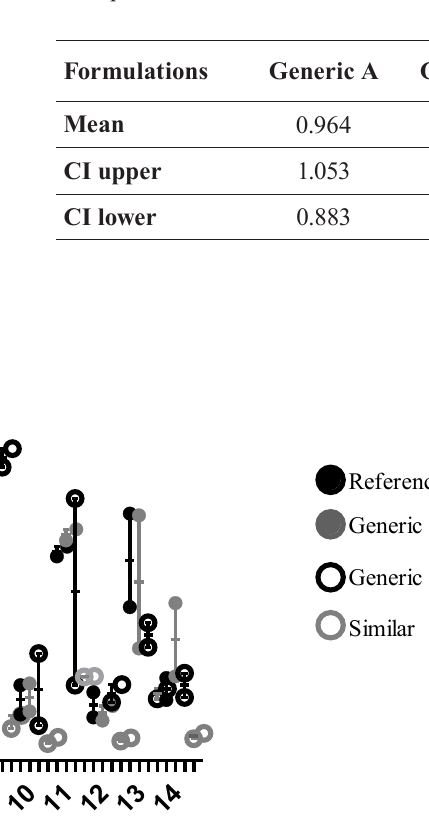
TABLE III - In vivo bioequivalence assessment ratio of products containing mupirocin (generic A, B and similar) compared to the reference, Bactroban®